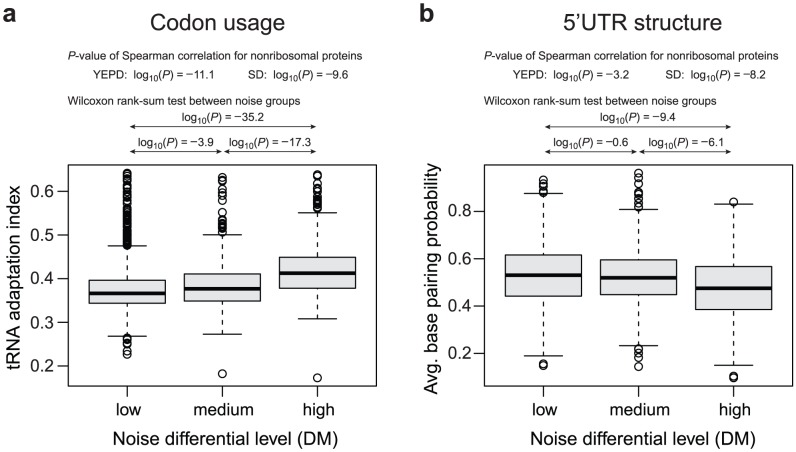
Comparison of translation related mRNA features:(a) codon usage (tRNA adaptation index and (b) average base pairing probability at the 5′ UTR mRNA structure for different noise differential levels. The nonribosomal genes were subdivided into three groups: low, medium and high noise genes, according to their noise differential levels in YEPD and SD media.